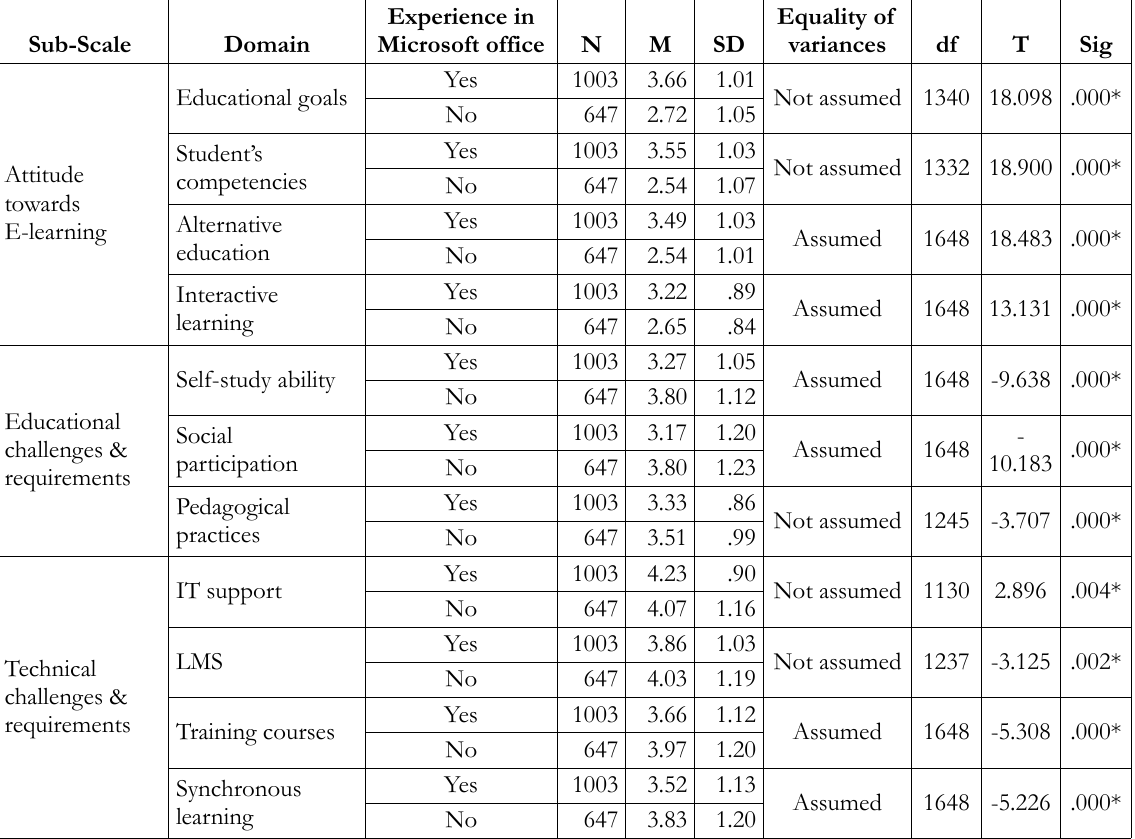
Table 10. Comparing groups of experienced undergraduates and unexperienced